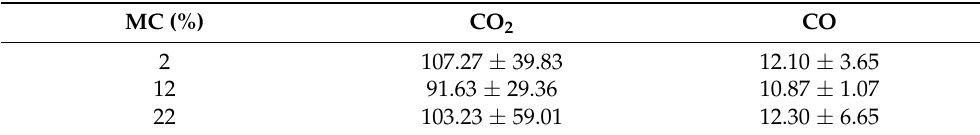
Table 1. The EF of CO 2 and CO from the smouldering combustion